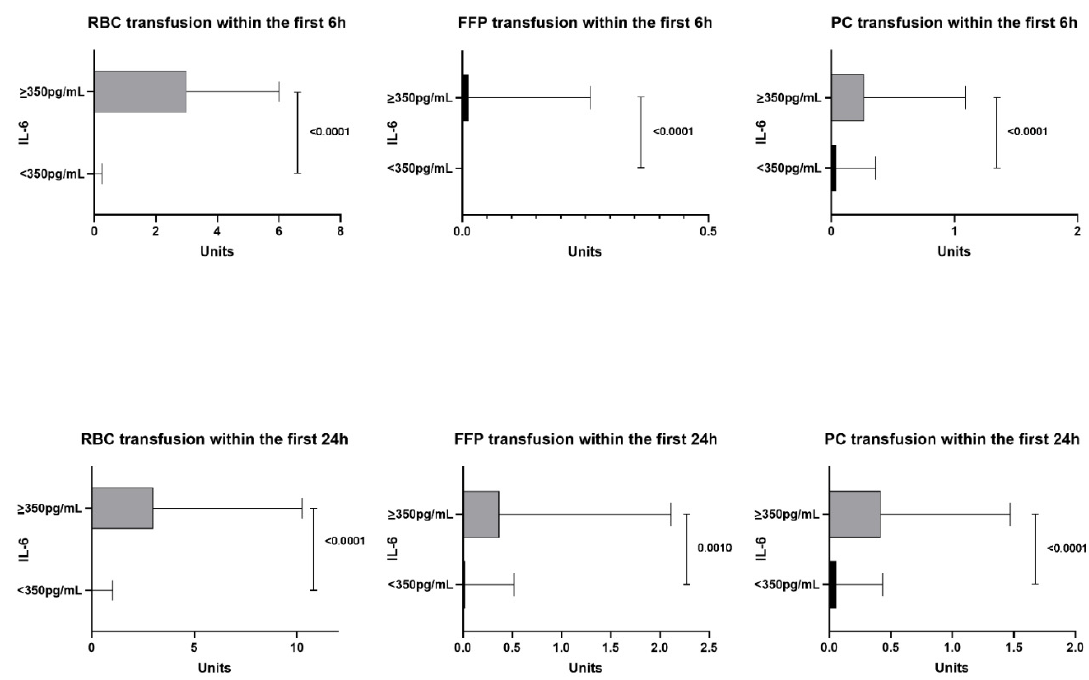
Figure 3. RBC, FFP and platelet concentrate transfusion of allogeneic blood products in the high-IL-6 group ( ≥ 350 pg/mL) and the low-IL-6 group (<350 pg/mL). IL-6, interleukin 6; RBC, red blood cells; FFP, fresh frozen plasma; PC, platelet concentrates.